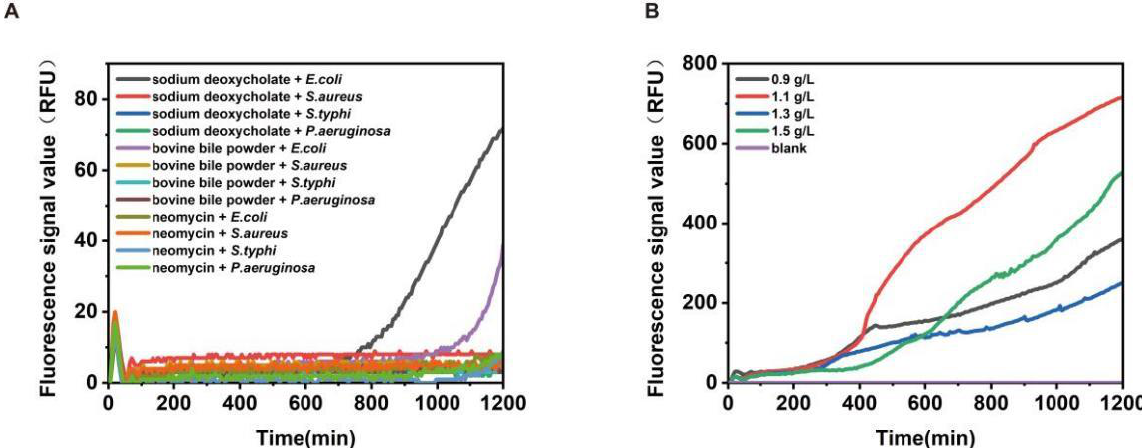
Figure 4. Optimization of media formulations. ( A ) shows that sodium deoxycholate works best. ( B ) shows that sodium deoxycholate had the lowest inhibitory effect on E. coli at 1.1 g/L.